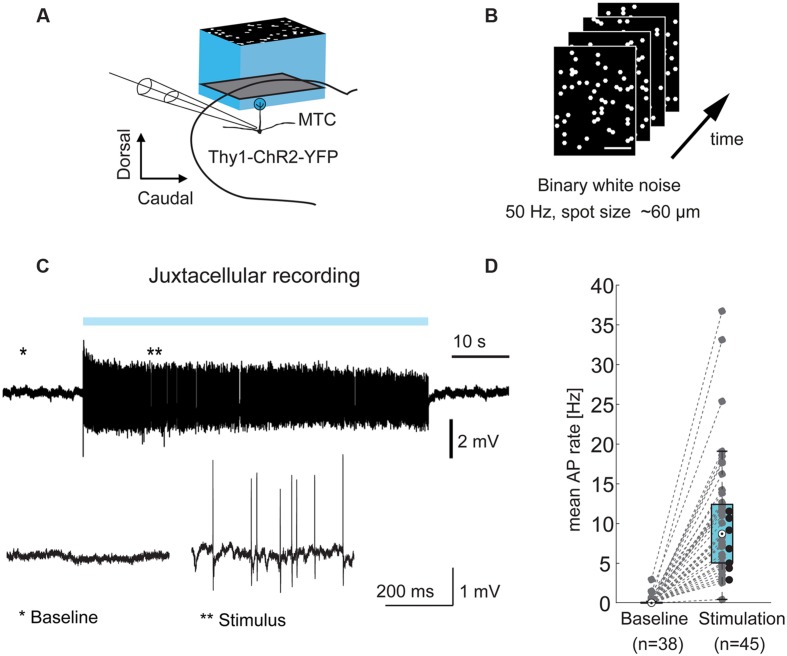
Optical stimulation drives MTCs. (A) Experimental setup: olfactory bulb (OB) mitral and tufted cells (MTCs) expressing ChR2 (Thy1-ChR2-YFP) were stimulated using a projection system (digital mirror device, blue LED, central wavelength ∼460 nm). Left, MTCs were recorded in juxtacellular or whole-cell configuration during light-stimulation of the dorsal OB. (B) Frames from a stimulation movie (3,000 frames) with binary dense white noise; on-probability for individual spots in any given frame is 10%. (C)
Top, example trace from a juxtacellular recording of a MTC during 1 min dense noise stimulation. Blue bar, stimulus; bottom, zoom-in on highlighted periods; (D) AP rate without (baseline, n = 38) and during optical stimulation (n = 45 MTCs), recorded in juxtacellular or whole-cell configuration. Black dots correspond to seven cells without sufficient recorded baseline.